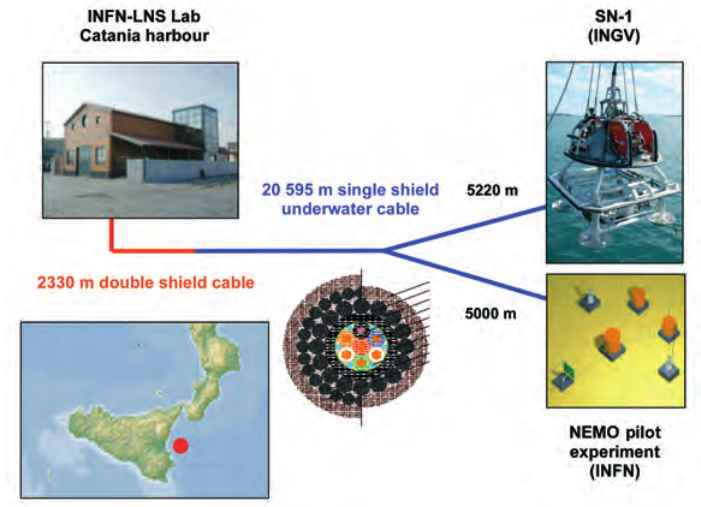
Fig. 14. Sketch of the INFN cable from the shore laboratory in Catania harbour to a plateau of the Malta es- carpment located about 25 km east of Etna volcano ( > 2000 m w.d.). A photograph of SN-1 is also shown in the top-right corner (Favali et al. , 2003). The geographic location of the observatory is indicated by a red dot on the map in the bottom-left corner (2060 m